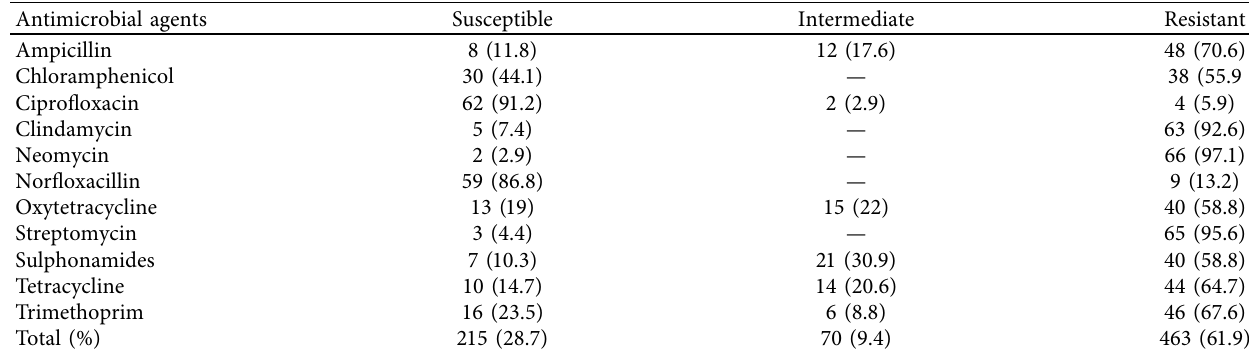
Table 3: Antimicrobial susceptibility patterns in Escherichia coli isolates.